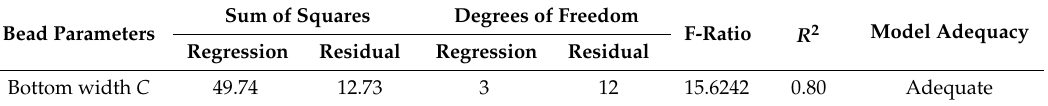
Table 3. Analysis of variance (ANOVA) for testing the adequacy of models.